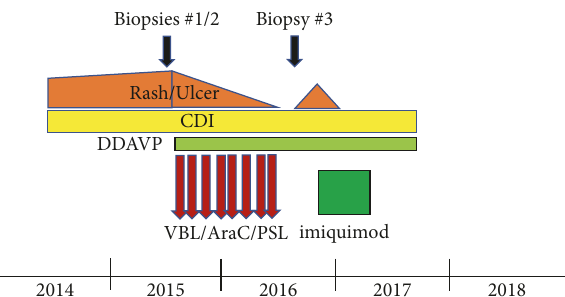
Figure 3: Clinical course and treatment. Biopsies #1/2 were done on the axillary ulcer and the retroauricular cutaneous lesions and biopsy #3 was done on the relapsed retroauricular cutaneous lesion. Diagnosis of LCH was made after biopsy #1. Pathological findings of #2 and #3 were almost identical to those of #1 shown in Figure 2. Details of the chemotherapy (VBL/AraC/PSL) and imiquimod regimens are described in the text. Symptoms of central diabetes insipidus were controlled by